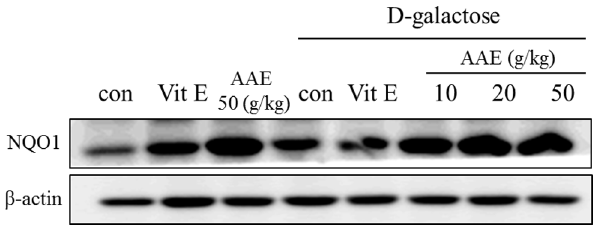
Figure 5. Increased NQO1 expression in small intestine of mice administered with AA. C57BL/6J mice (5-week old, n=10) were treated with AA extract with and without D-galactose exposure for 6 weeks, and then epithelium of small intestine was scraped and subjected to western blot for the determination of NQO1 level.